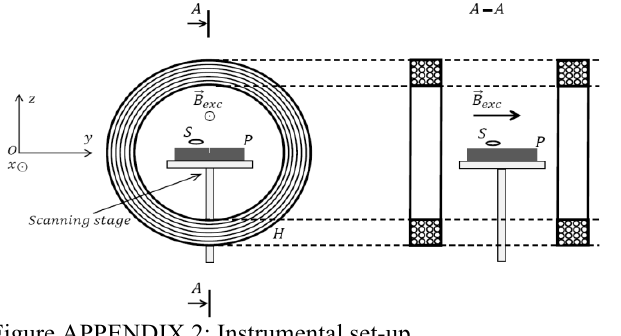
Figure APPENDIX 2: Instrumental set-up